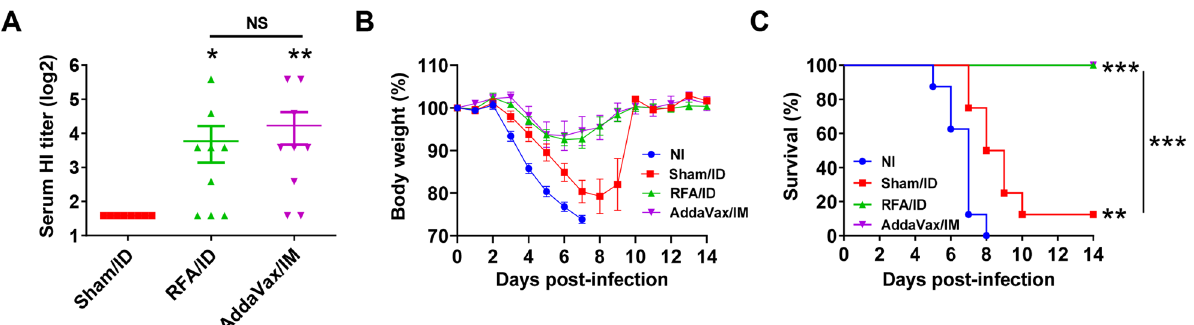
Figure 2. RFA boosts monovalent H3N2 vaccination. BALB/c mice were subjected to RF or sham treatment followed by ID delivery of 0.1 µg H3N2 vaccine (HA equivalent) into RF or sham-treated skin or intramuscularly injected with the same vaccine dose in the presence of AddaVax or left non-immunized (NI). Serum HI titer was measured 3 weeks later and shown in ( A ). Mice were then challenged with a lethal dose of homologous H3N2 viruses (50 × LD50). Body weight change ( B ) and survival ( C ) were monitored daily for 14 days. n = 8–9. One-way ANOVA with Dunn’s multiple comparison test was used to compare differences among groups in ( A ). Log-rank test with Bonferroni correction was used to compare differences of survival between NI and other groups or otherwise specified in ( C ). *p < 0.05; **p < 0.01; ***p < 0.001. NS not